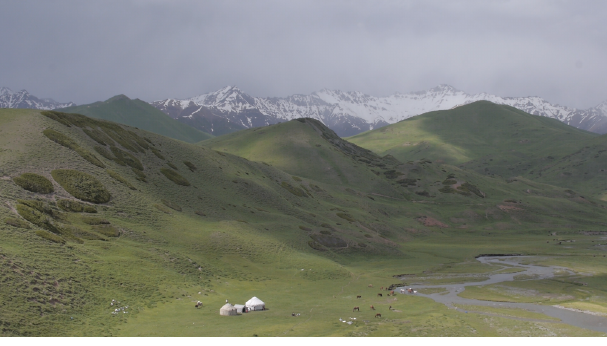
Fig. 2 . High summer pasture in Naryn